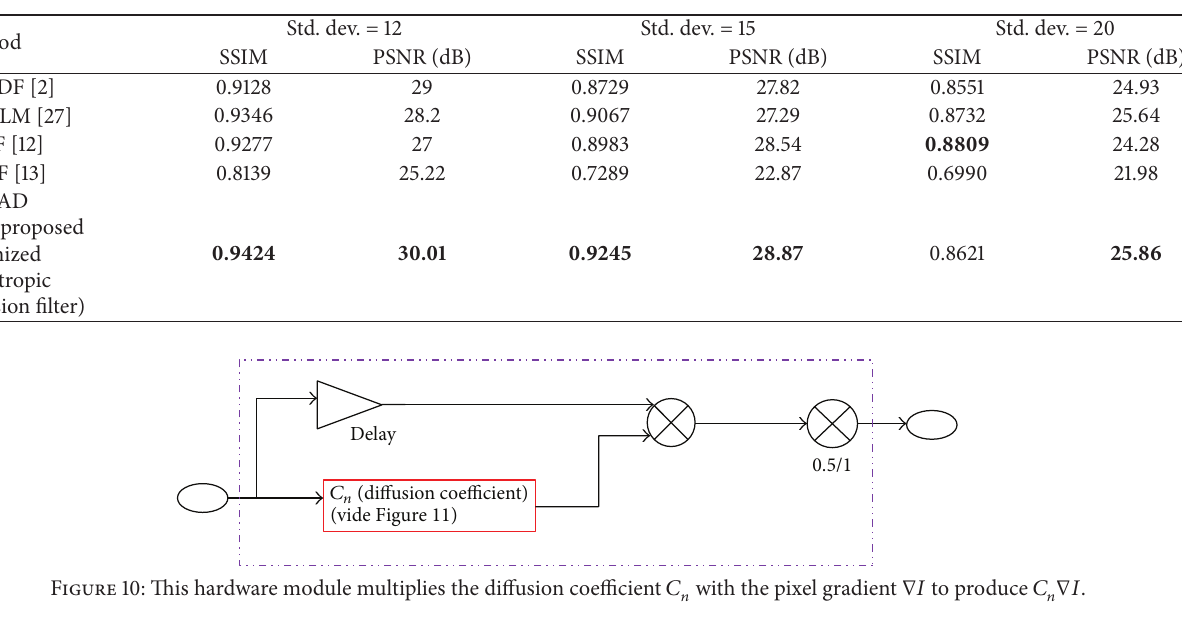
Table 2: Quality measures (performance metrics): SSIM (structural similarity) and PSNR (peak signal-to-noise ratio) for the experiments. For each column, the best value has been highlighted for three different noise standard deviations. Our proposed technique OAD (optimized anisotropic diffusion) shows better result except for the SSIM parameter for standard deviation, 20. Comparison has been made with different types of benchmark edge preserving denoising filters.